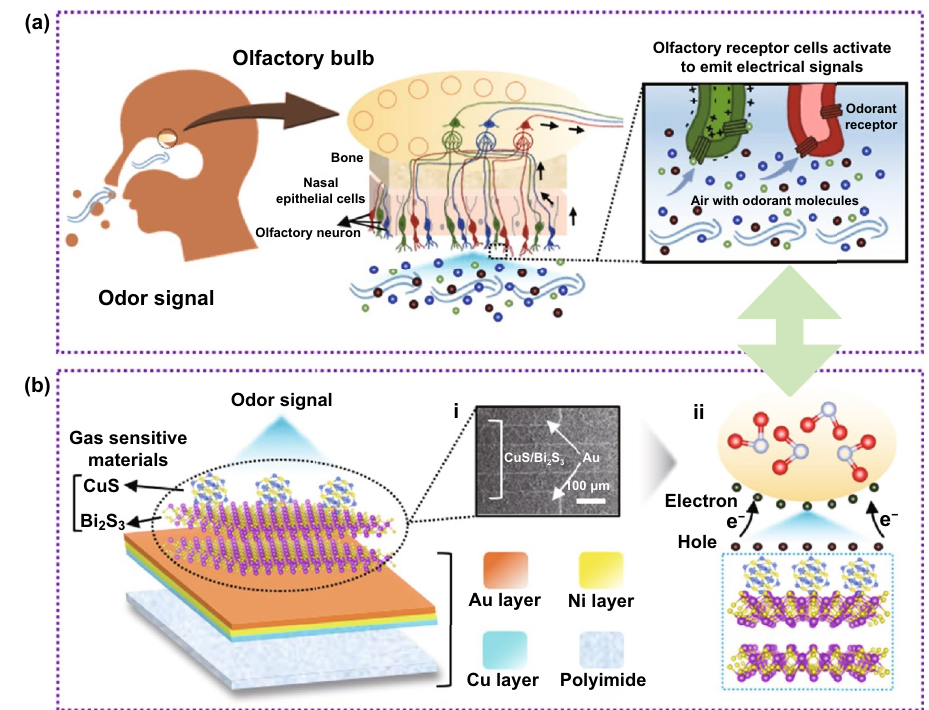
Fig. 2 a Schematic diagram of biological olfactory system. b Schematic diagram of artificial olfactory neuron sensing based on CuS QDs/Bi 2 S 3 NSs